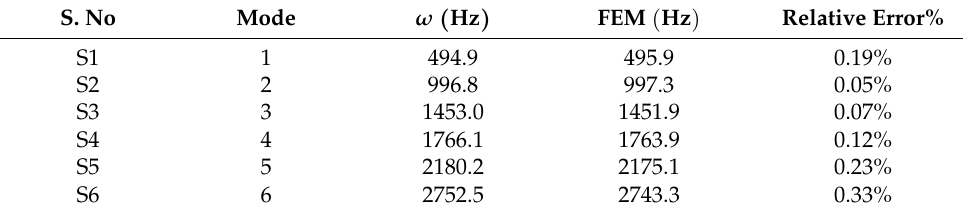
Table 5. Comparison with FEM (GPL-UD).